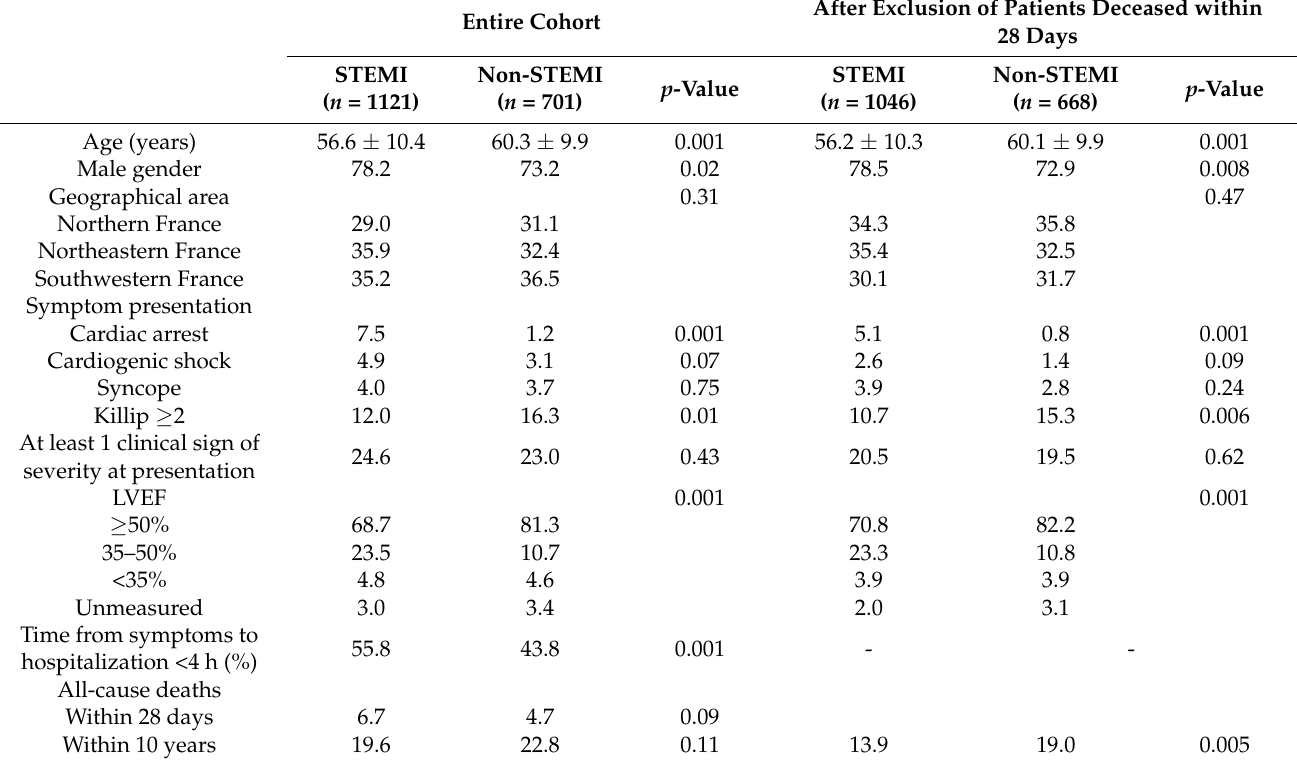
Table 1. Patients’ characteristics according to the type of acute coronary syndrome. After Exclusion of Patients Deceased within Entire Cohort 28